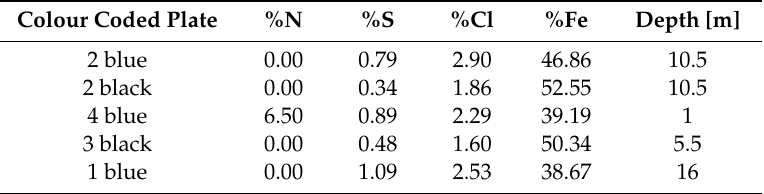
Table 2. Elemental composition (wt%) of corrosion product collected from colour coded plates. Colour Coded Plate